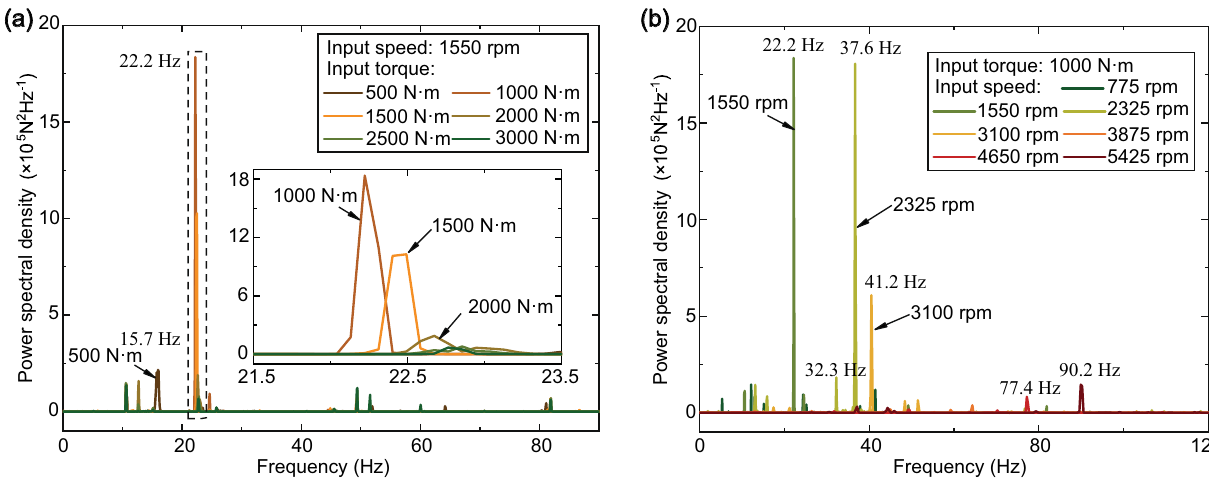
Fig. 13 Frequency components of the measured bearing load under conditions of a different torques and b different speeds